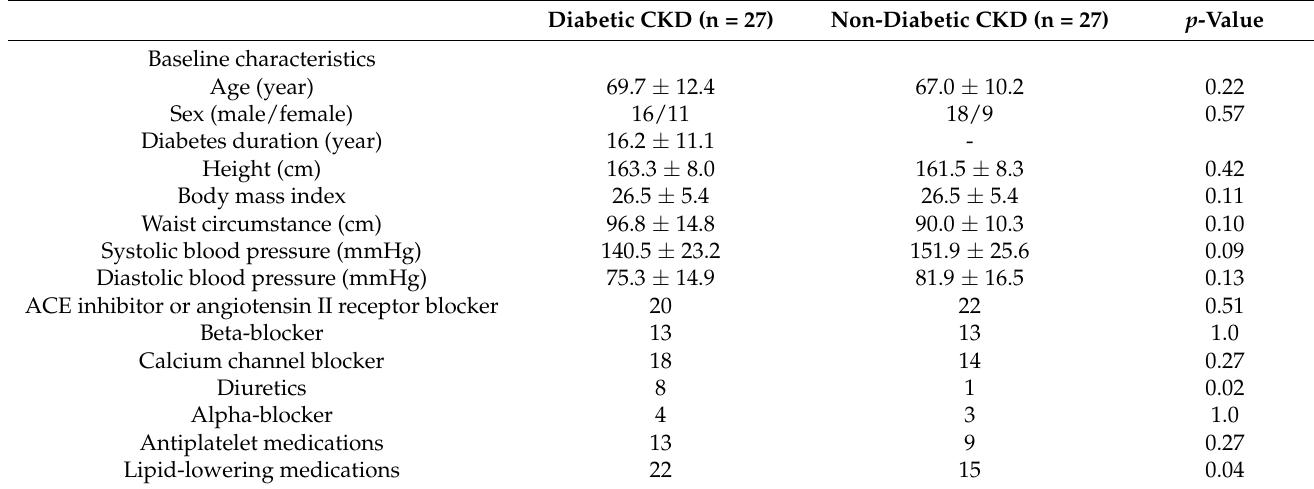
Table 1. Baseline characteristics of patients with diabetic and non-diabetic chronic kidney